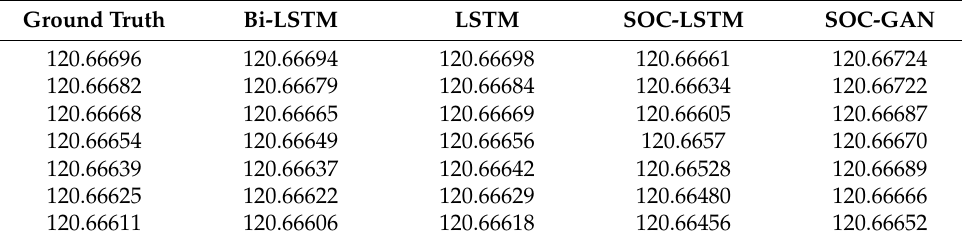
Table 5. Ship trajectory segment prediction performance on longitude data samples. Ground Truth